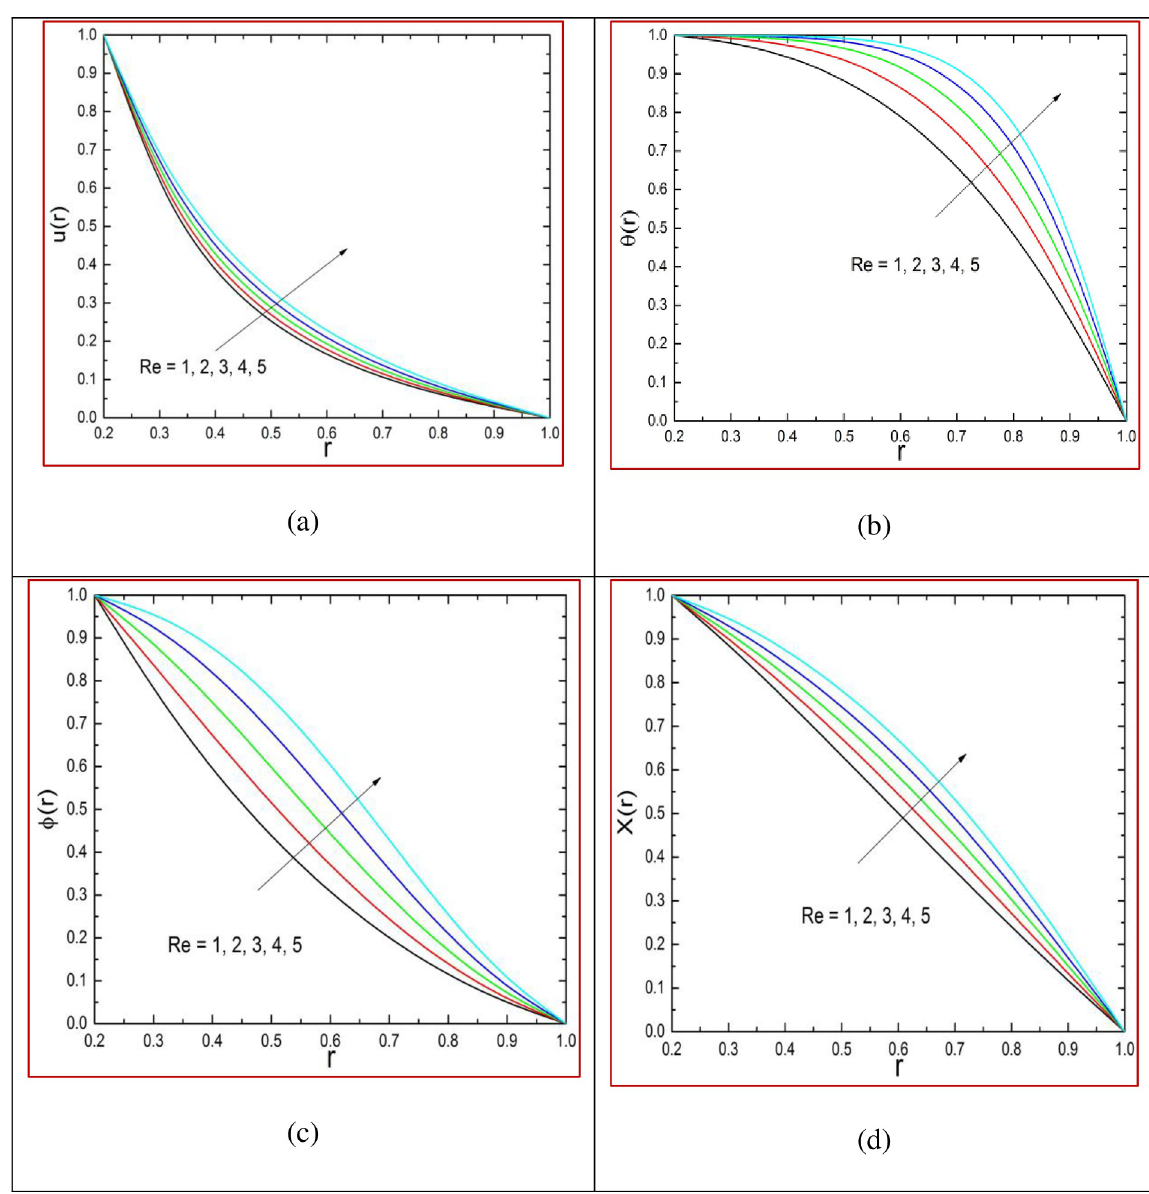
Fig 2. The impact of Reynolds number on the fluid